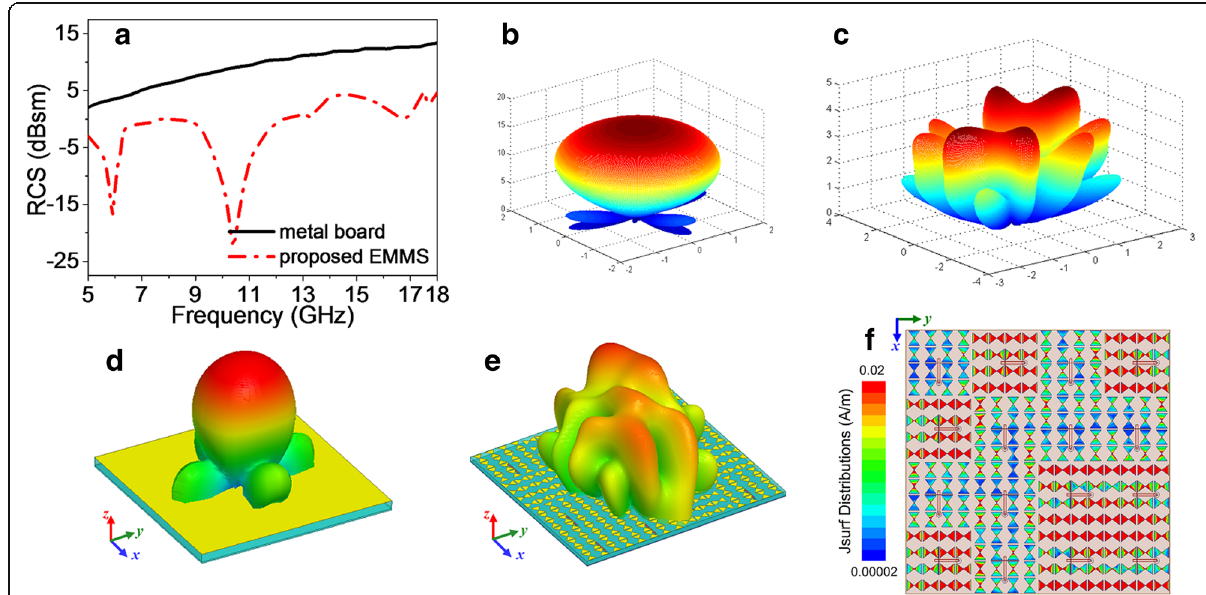
Fig. 9 Diffusion scattering properties of the EMMS under normal incidence. a Radar cross section versus frequency compared with a same-sized metal board. Scattering patterns calculated by Eq. (1) for metal board ( b ) and EMMS ( c ). Scattering patterns obtained by full-wave simulations at 6 GHz for metal board ( d ) and EMMS ( e ). f Surface current distribution across the EMMS at 6 GHz